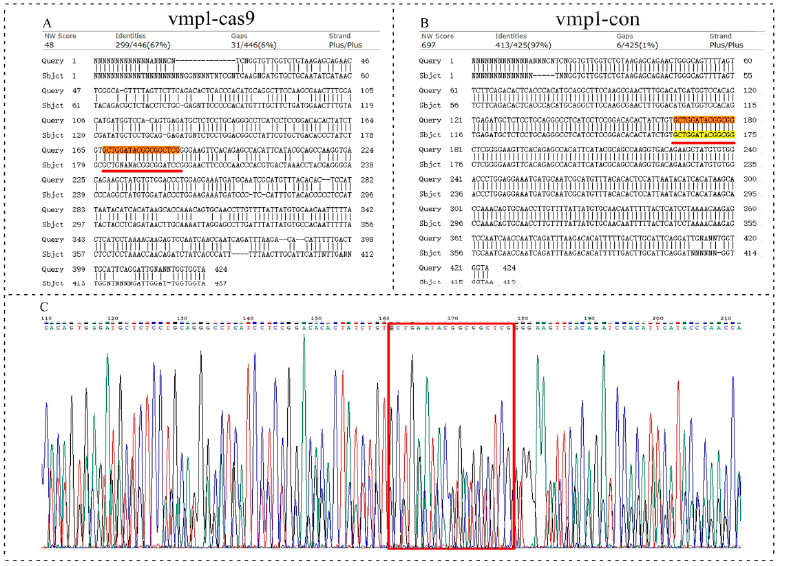
Figure 12. The sequence detection results for vmp1 knockout. ( A ) Alignment of caudal fin sequences from the control and the vmp1 -cas9-knockout F0-generation adult zebrafish. ( B ) Alignment of caudal fin sequences from the control and the vmp1 -con F0-generation adult zebrafish. ( C ) Sequencing of the 24 hpf embryos from the vmp1 -cas9-knockout F1-generation fish. Highlight red line and red box: indicates the knockout target site